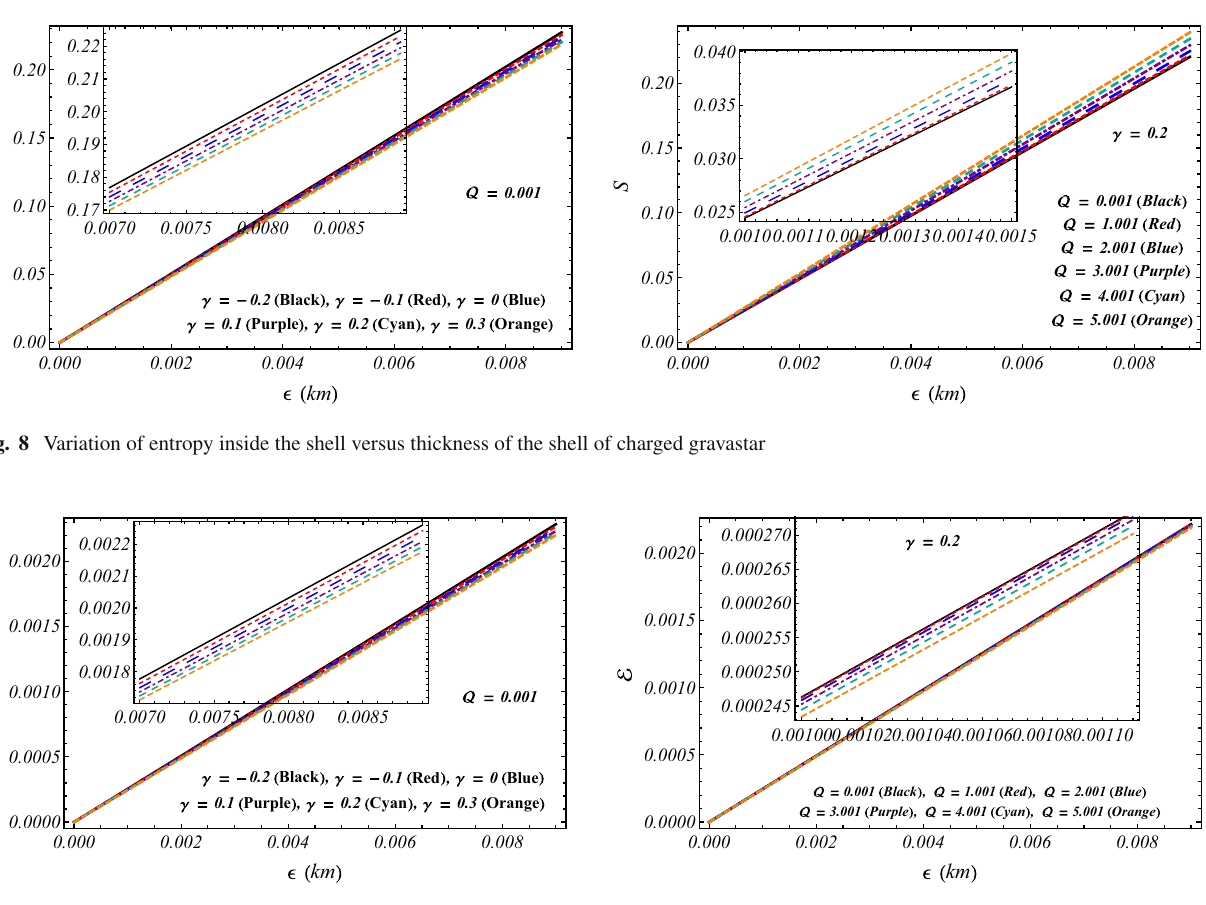
Fig. 9 Variation of energy inside the shell versus thickness of the shell of charged